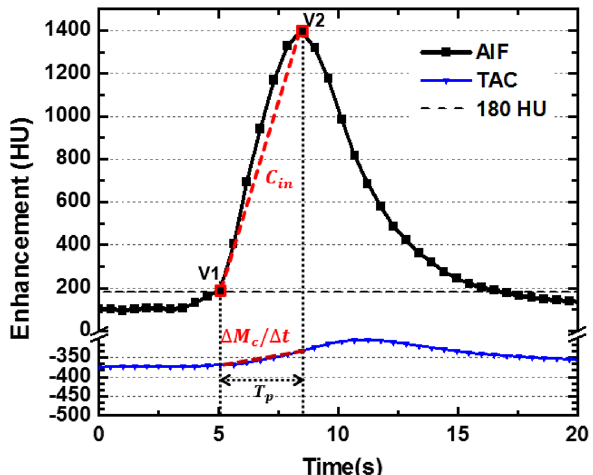
Figure 3. Two-volume FPA perfusion protocol. The integrated contrast enhancement change ( � M c /� t ) within the lung compartment is measured by the tissue time attenuation curve (TAC, blue line). The average input concentration ( C in ) is estimated from the pulmonary arterial input function (AIF, black line) at V1 and V2. T p is the time-to-peak